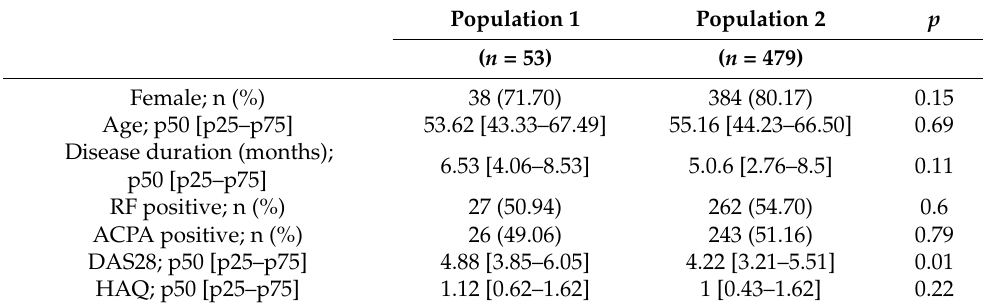
Table 2. Baseline clinical characteristics of the populations